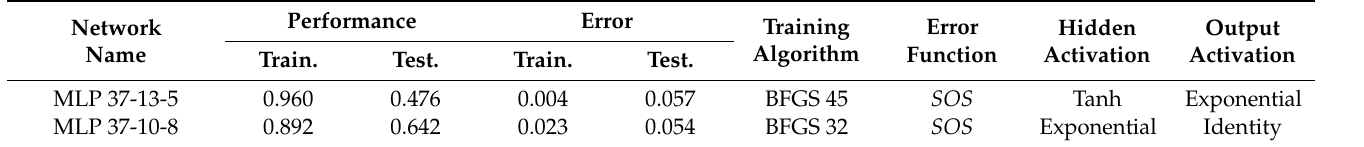
Table 1. Artificial neural network (AAN) model summary (performance and errors) for training, testing, and validation